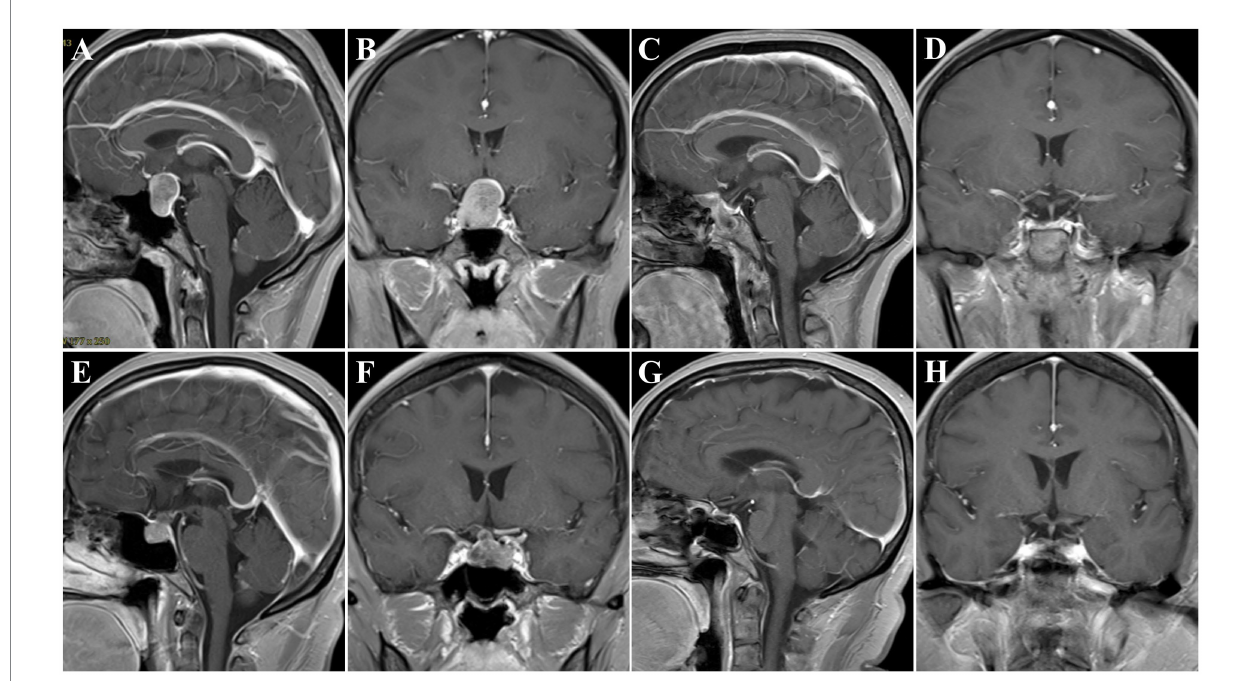
FIGURE 4 Preoperative and postoperative T1 MR images. (A–D) Patient No. 2, preoperative sagittal (A) and coronal (B) images showing a PitNET, Knosp grade 2. Three-month postoperative sagittal (C) and coronal (D) images showing GTR. (E–H) Patient No. 8, preoperative sagittal (E) and coronal (F) images showing a PitNET, Knosp grade 0. Three-month postoperative sagittal (C) and coronal (D) images showing